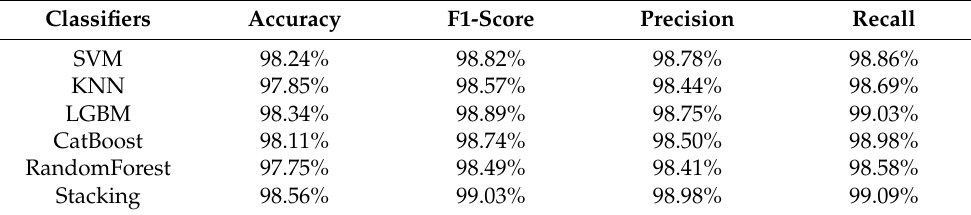
Table 2. CICMalDroid2020 detection results.